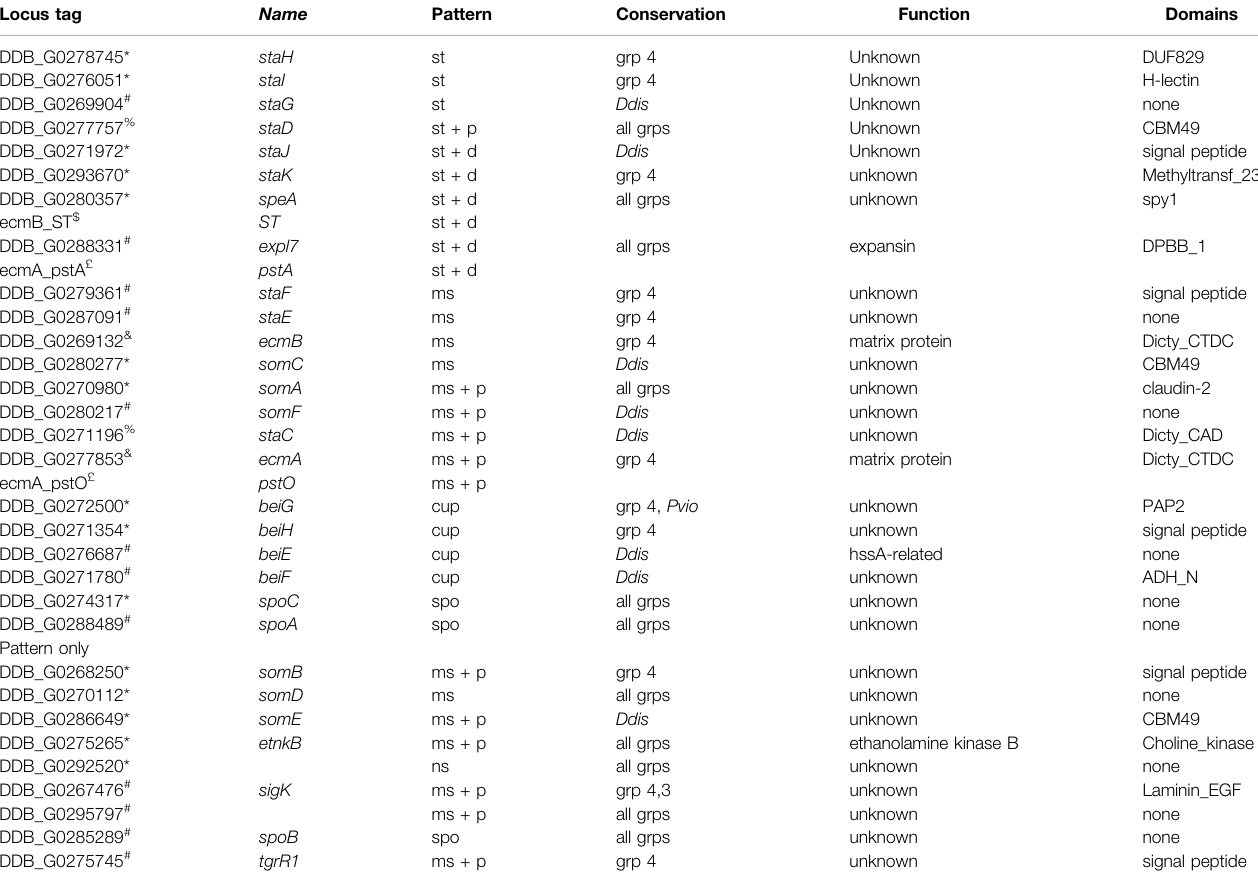
TABLE 1 | Gene expression patterns, conservation and function. Locus tag